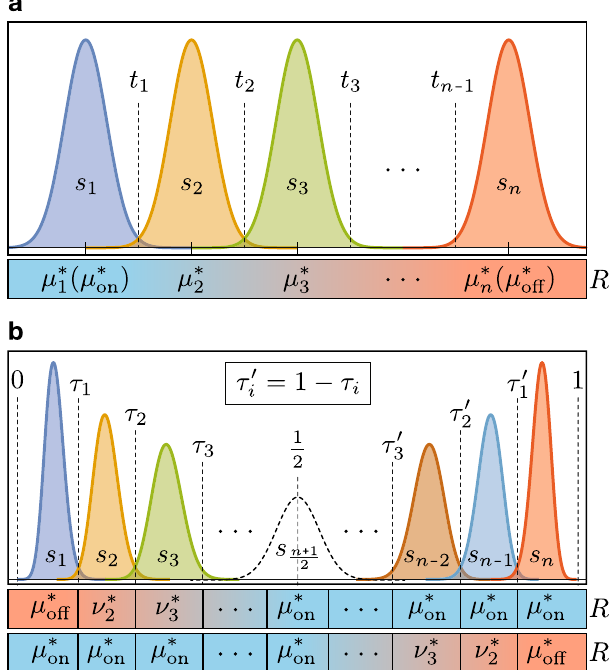
Figure 2. State distribution and threshold location for a multilevel memory. ( a ) Resistance-based states, using a single log-normally distributed resistive device to encode information. ( b ) Ratio-based states, using a pair of devices to encode information. The shape of the distributions is produced using equations (SM. 1.2) and (SM.1.4) (located in Supplementary Note 1) with optimal parameters located in Supplementary Note